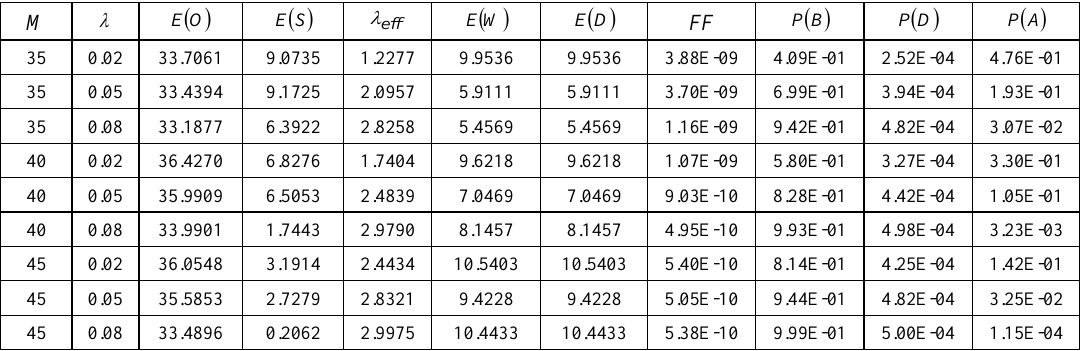
Table 1. Performance measures by varying the number of operating machine ( ) M and the failure rate of operating machine ( ) 